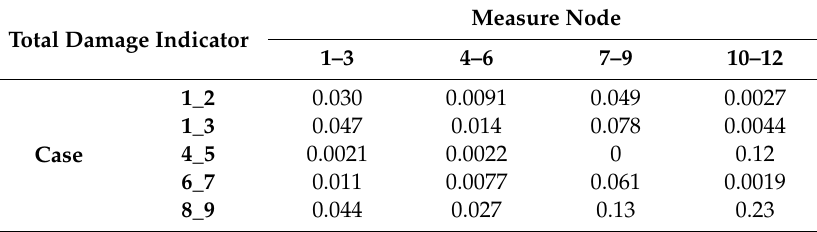
Table 5. Total damage indicators of every case using the TVSR